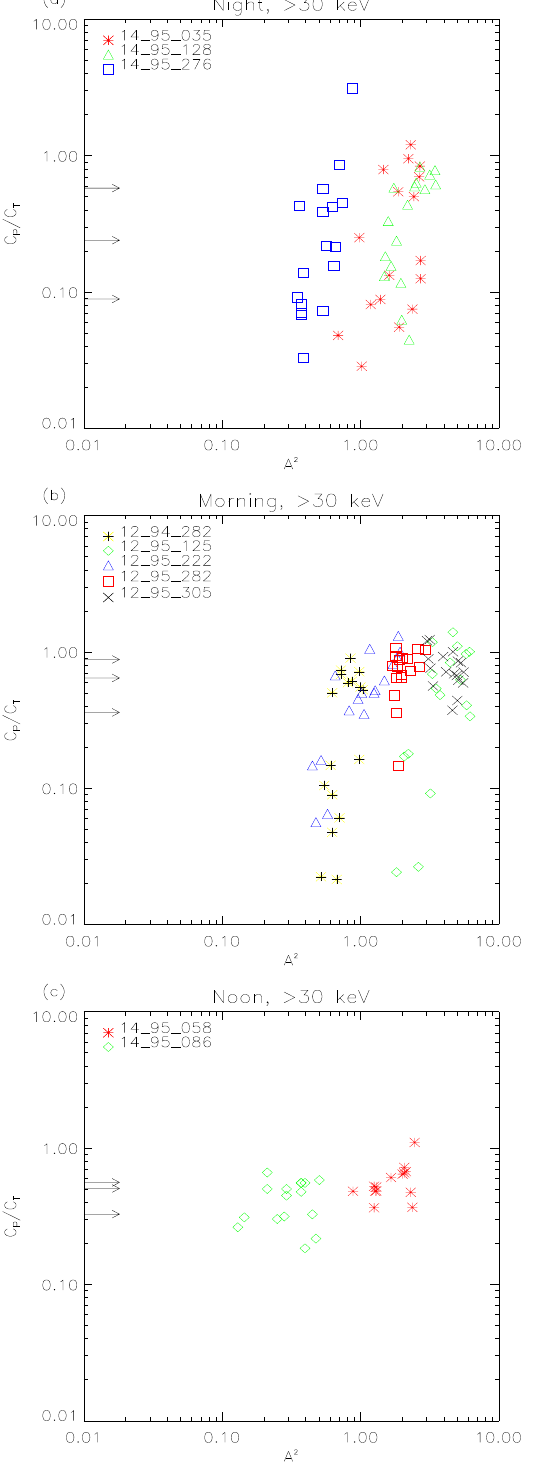
Figure 9: Ratio of precipitated to trapped 30 keV count rates against A 2 at 2-second intervals for the 10 Kilpisj¨arvi overpasses, divided into night, morning, and noon sectors. (The arrows mark the medians and quartiles.) 22